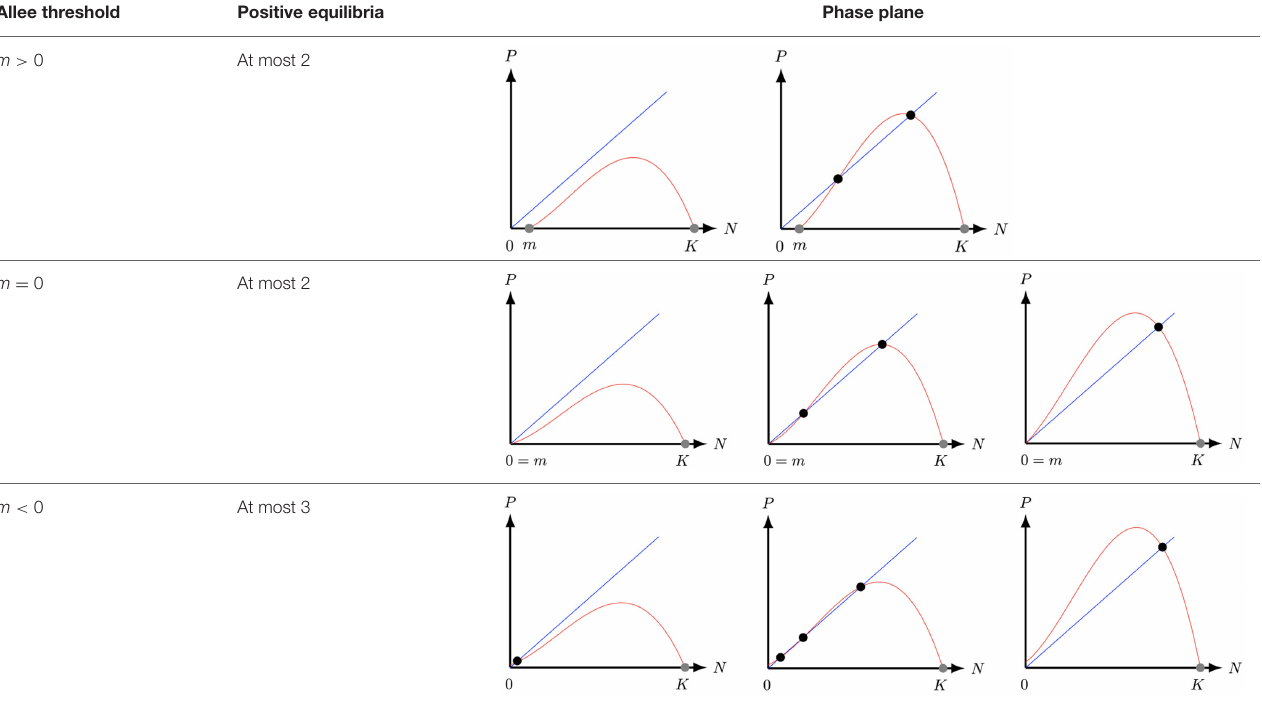
TABLE 1 | Number of equilibria of system (2) with strong ( m > 0), degenerate weak ( m Allee